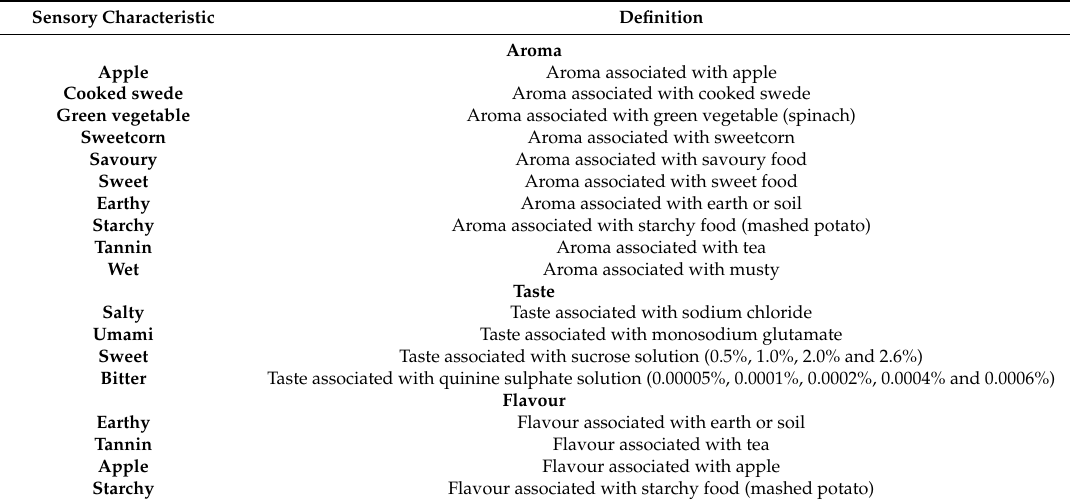
Table 2. Definition of sensory characteristics associated with 7 batches of steamed-pureed turnip and references used during vocabulary